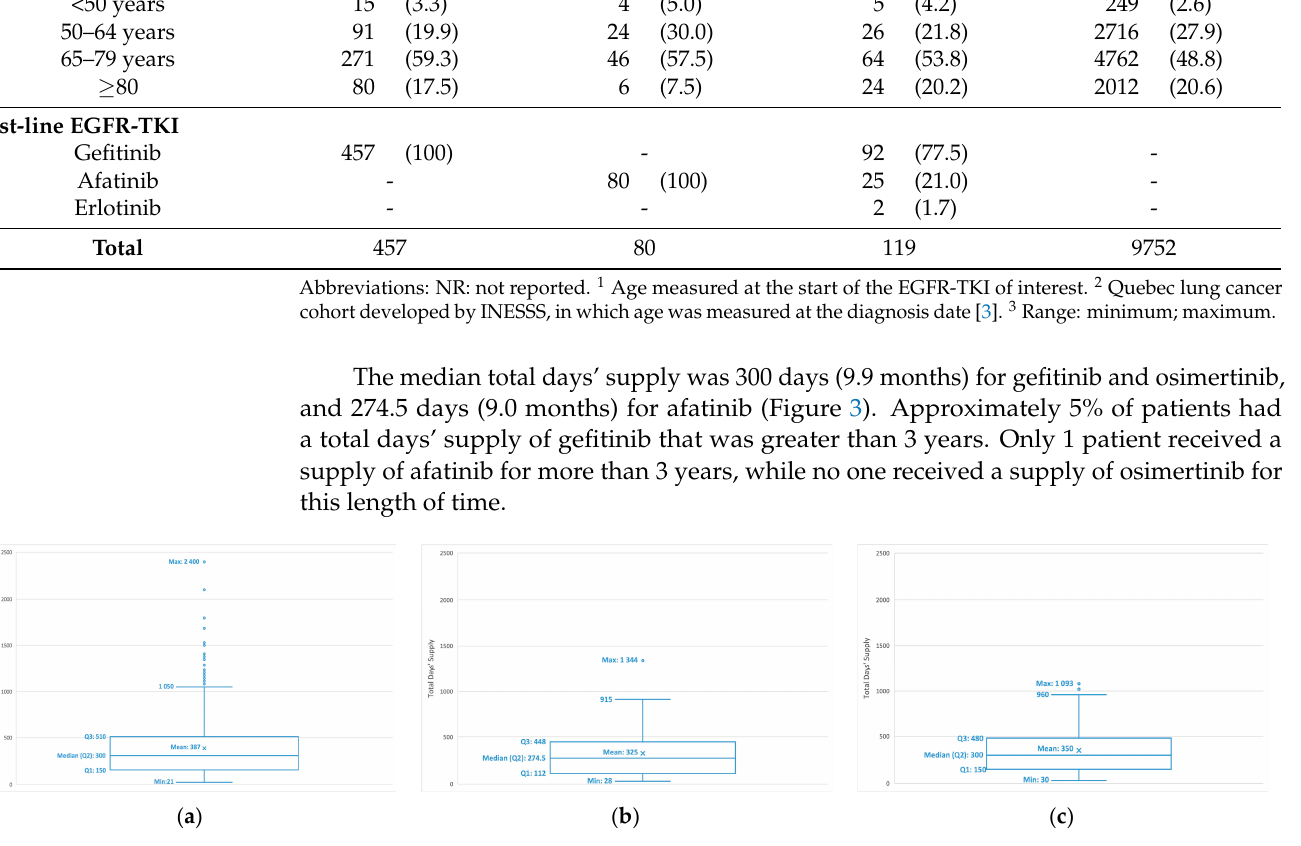
Table 2. Characteristics of patients in EGR ‐ TKI cohorts.